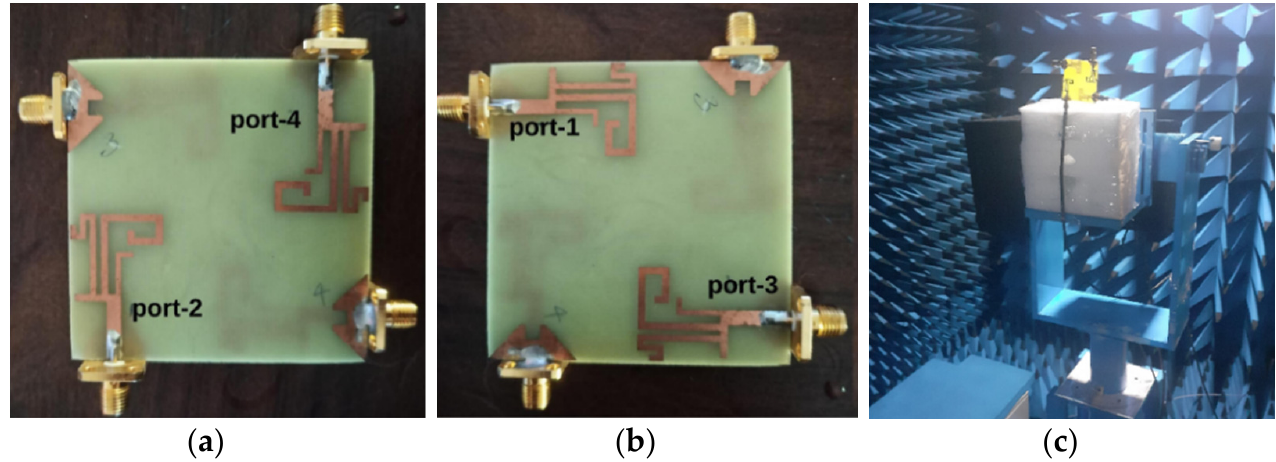
Figure 8. Prototype of the DS MIMO antenna ( a ) front view, ( b ) back view, ( c ) measurements in an anechoic chamber.